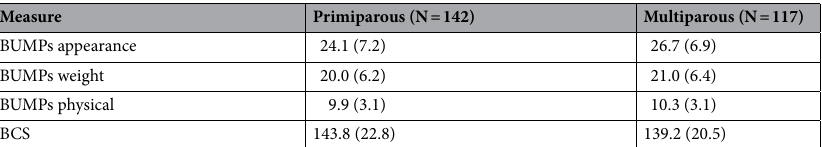
Table 5. Means (SD) of primiparous and multiparous women for the different body satisfaction measures. For the BCS higher values represent greater satisfaction, higher BUMPs values represent greater dissatisfaction. BCS body cathexis scale, BUMPs body understanding measure for pregnancy